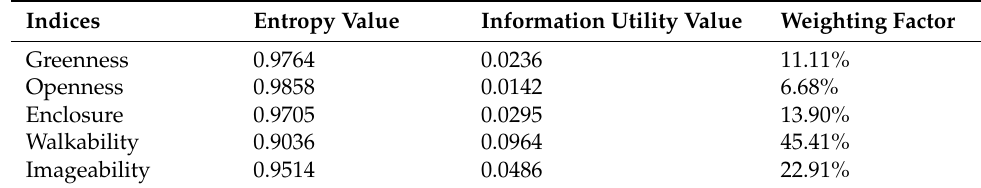
Table 4. Entropy method weighting